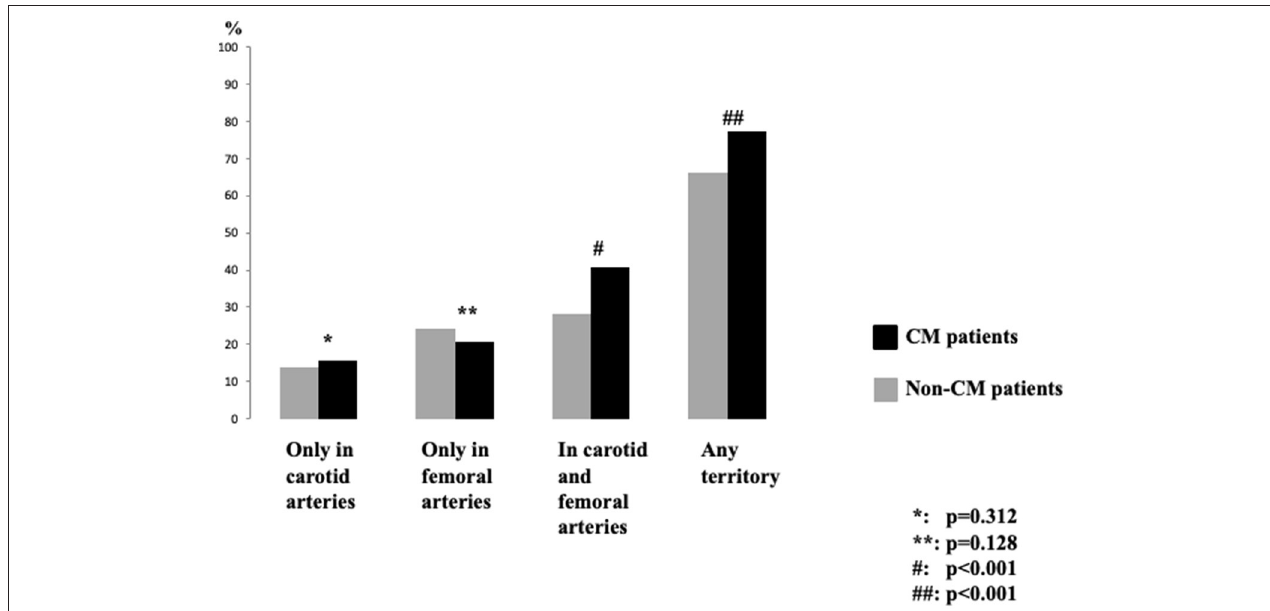
FIGURE 1 | Prevalence of atheromatosis between cerebral microangiopathy patients according to the location of atheroma plaque. CM, cerebral